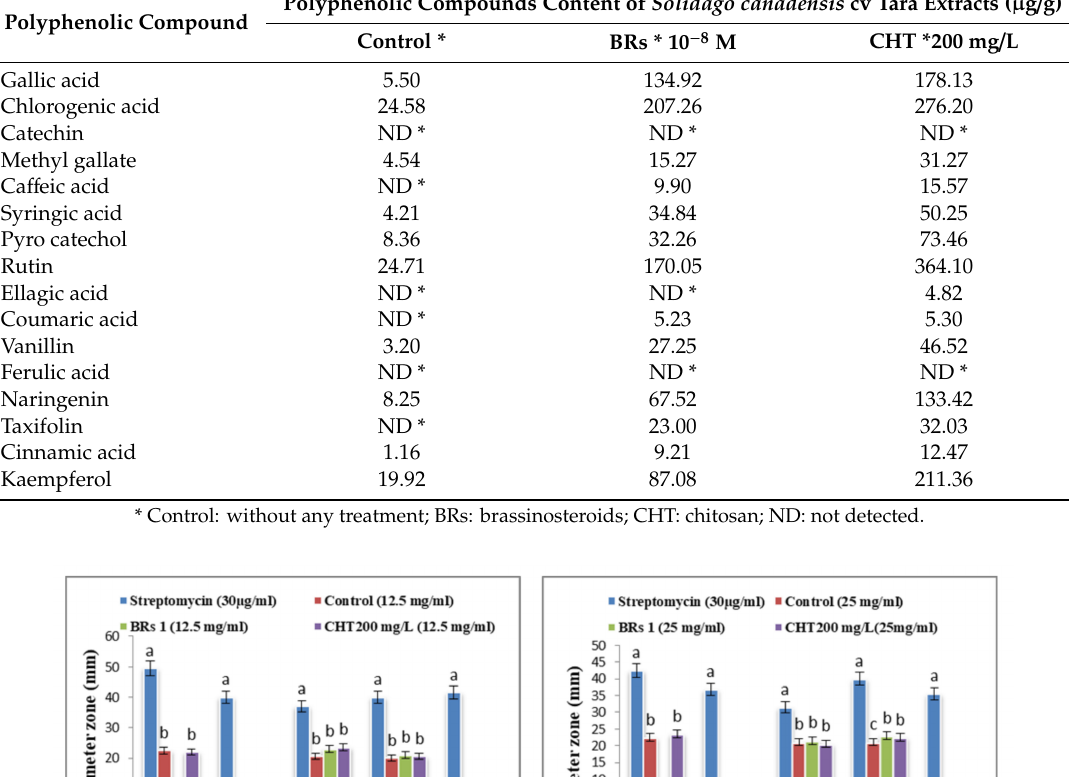
Table6. Polyphenoliccompositionof Solidagocanadensis cv. TaraextractbyHPLCquantificationanalysis. Polyphenolic Compound